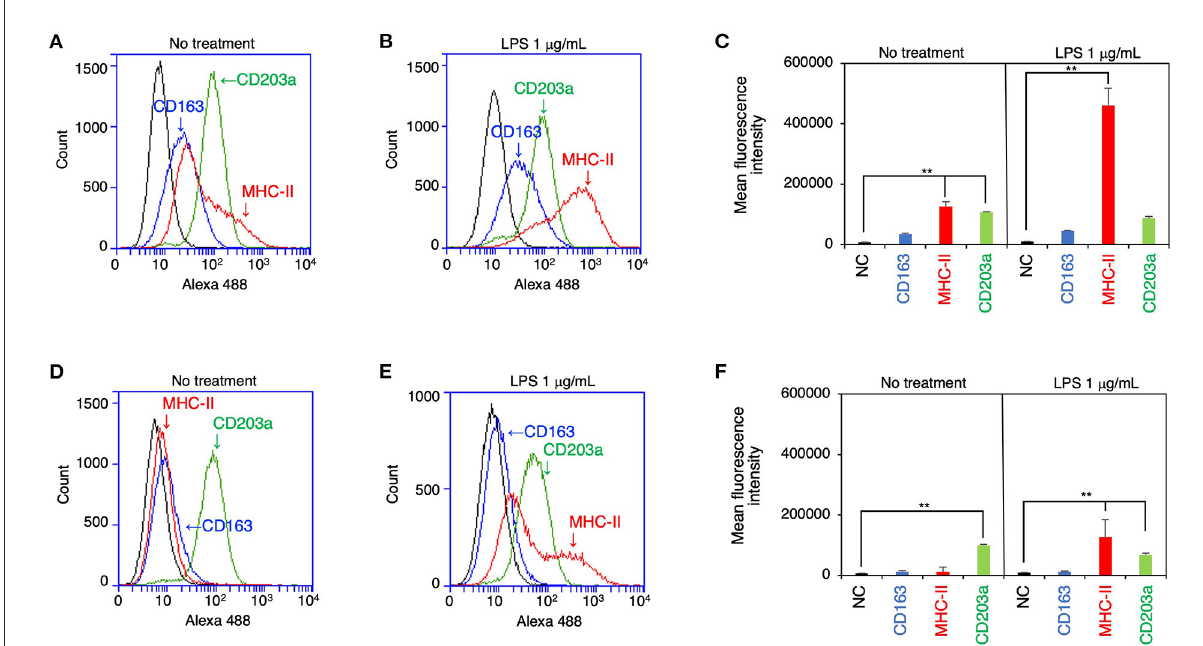
FIGURE2 Flow cytometric analyses of IPLuM and IPIM. IPLuM (A–C) or IPIM (D–F) were treated with (B,E) or without 1 µ g/mL LPS (A,D) for 1 day. Then, the cells were reacted with mouse monoclonal anti-CD163 (blue line), anti-CD203a (green line), or anti-MHC-II (red line) antibodies, before being labeled with Alexa Fluor 488-conjugated anti-mouse IgG antibodies (Alexa 488). The cells treated with Alexa 488 alone were used as a negative control (NC) (black line). The flow cytometry histograms are representative of three independent experiments (A,B,D,E) , and the MFI data are expressed as mean ± SEM values ( n = 3, ** p < 0.01 vs. NC) (C,F)